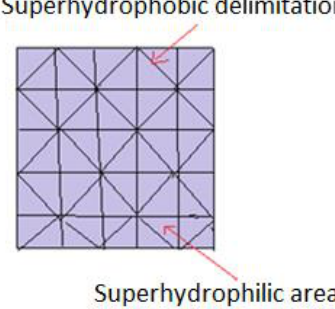
Figure 6. Schematic representation of patterns joining superhydrophobic with superhydrophilic